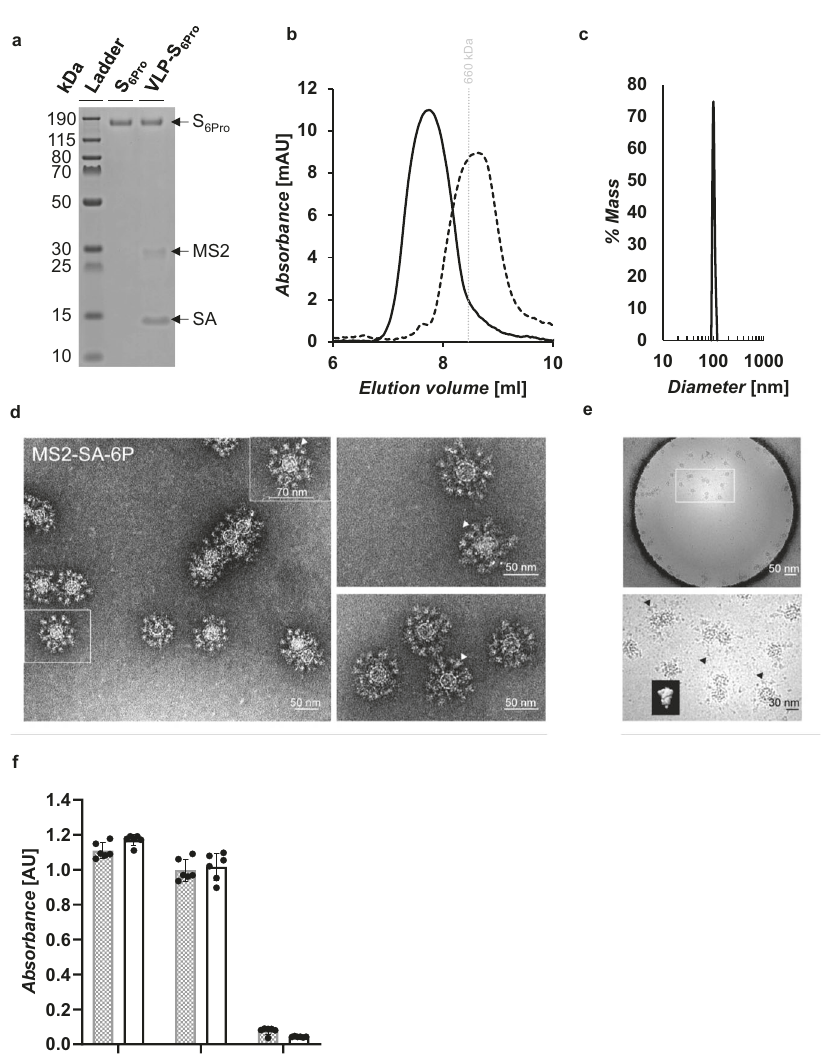
Fig. 3 Characterization of S6Pro and VLP-S6Pro. a SDS-PAGE characterization of S 6Pro and VLP-S 6Pro . The VLP-S 6Pro has been boiled to disrupt the streptavidin-biotin conjugation. The unprocessed gel is shown in Supplementary Fig. 3. b Size exclusion chromatography traces for S 6Pro (dashed line) and VLP-S 6Pro (solid line). The vertical gray line represents the peak elution volume of the molecular weight standard thyroglobulin (660 kDa). The column void volume is 7.2 mL. c Characterization of the VLP-S 6Pro (solid line) by dynamic light scattering. d Negative-stain transmission electron micrographs of S 6Pro incorporated on the surface of MS2-SA VLPs. Arrowheads (white) indicate the S 6Pro proteins on the VLP surface. e Cryo-EM of vitri fi ed VLP-S 6Pro . The inset shows a low-pass fi ltered to 10 Å volume of HexaPro structure (EMD: 22221, reported previously) for comparison. Arrowheads (black) indicate the representative S 6Pro proteins on the VLP surface. f Characterization of the binding of Fc-ACE2 (gray) and CR3022 (white) to S 6Pro and VLP-S 6Pro by ELISA (mean ± SD, n = 6: two independent assays, each with three technical replicates). Source data are provided in Supplementary Data